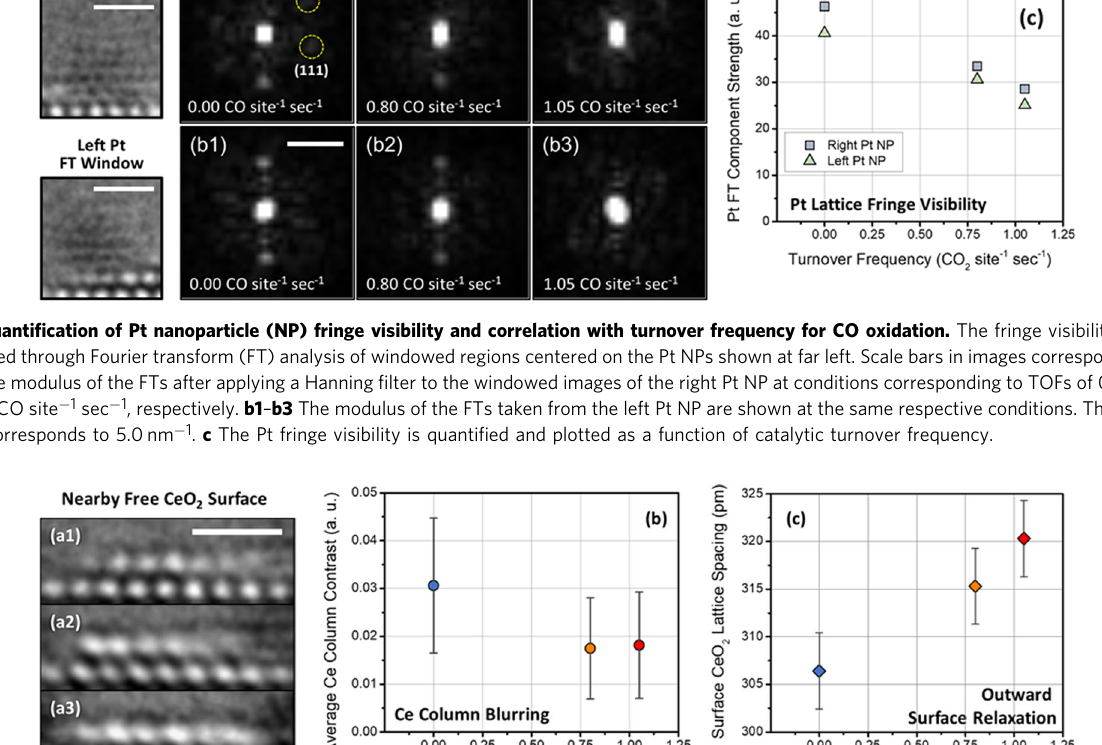
increases to 1.05 CO site − 1 sec − 1 , the blurring of the surface Ce becomes further pronounced to the point that the top layer appears as a nearly continuous band of intensity running parallel to the (111) CeO 2 support surface (Fig. 6(a3)). A similar blurring of the free surface Ce sites located at the opposite sides of the Pt nanoparticles can be observed in Fig. 4c. The blurring does not